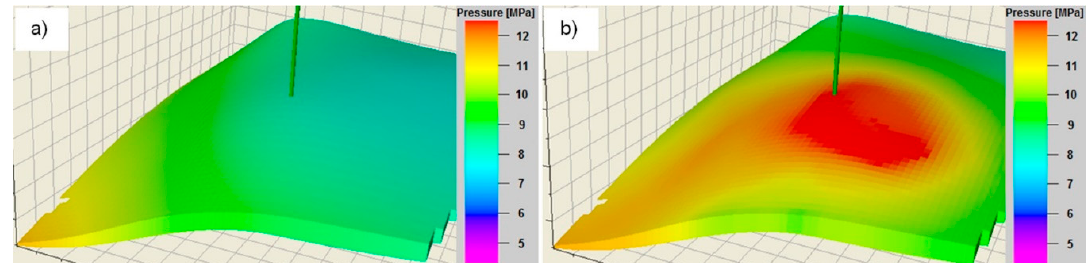
Figure 12. Distribution of pressure in the roof layer of the aquifer ( a ) before the start of injection and ( b ) after 25 years of injection .